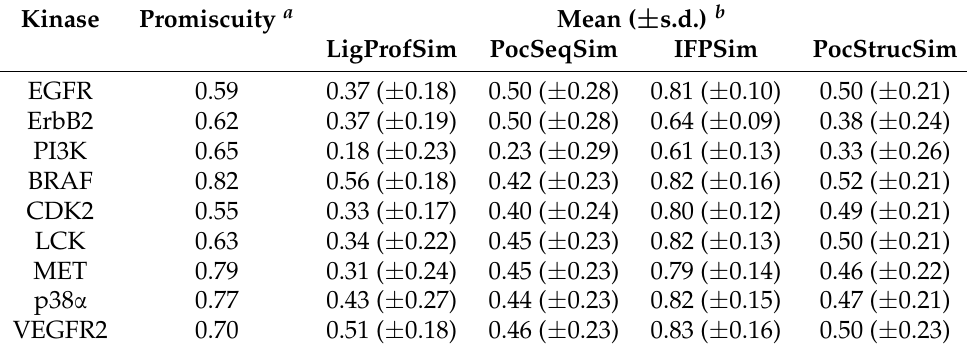
Table 4. Kinase promiscuity measures calculated as the ratio of ligands active on a specific kinase (column 2). In Columns 3–6, mean values and standard deviations (s.d.) of ligand profile similarity (LigProfSim), pocket sequence similarity (PocSeqSim), interaction fingerprint similarity (IFPSim) and